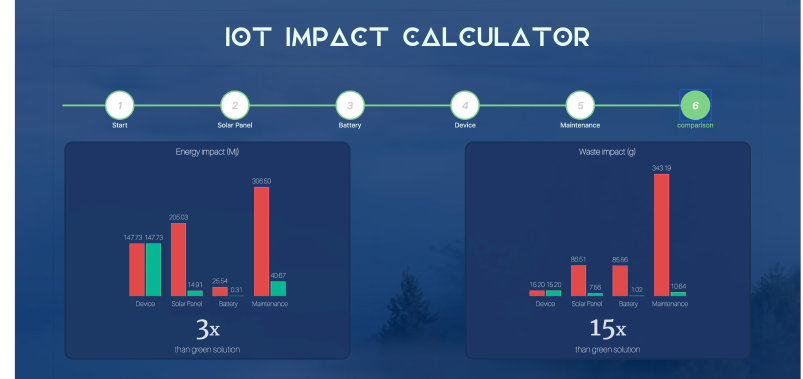
Figure 14. Web service user